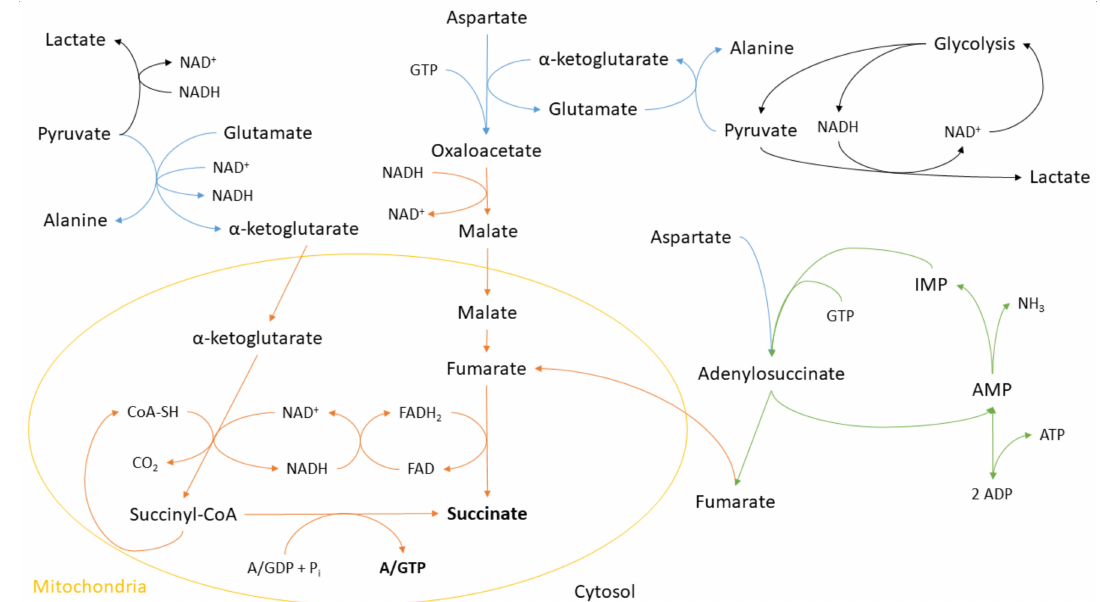
Figure 12. Succinate generation during anoxia. Anoxic succinate accumulation related to amino acid metabolism (blue arrows), glycolysis (black arrows), and purine nucleotide cycle (green arrows). Left: Transamination of pyruvate from glycolysis to alanine generates alpha-ketoglutarate from glutamate. Alpha-ketoglutarate can then be fueled into the TCA cycle, producing ATP/GTP via succinyl-CoA conversion to succinate. Middle: Alpha-ketoglutarate may also drive the formation of oxaloacetate from aspartate. Through reverse-functioning TCA cycle, malate is converted to fumarate and succinate, generating ATP and regenerating NAD + . Right: Aspartate can also contribute to fumarate generation in the purine nucleotide